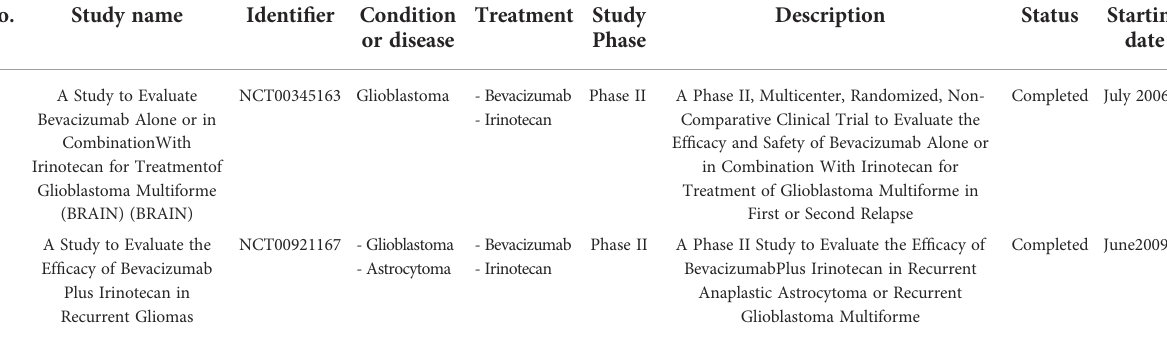
TABLE 3 A list of completed and ongoing clinical trials of combination treatment of Bev and Iri on GBM was obtained from www.clinicaltrials.gov (keywords: glioblastoma, bevacizumab, and irinotecan) until November 2022.